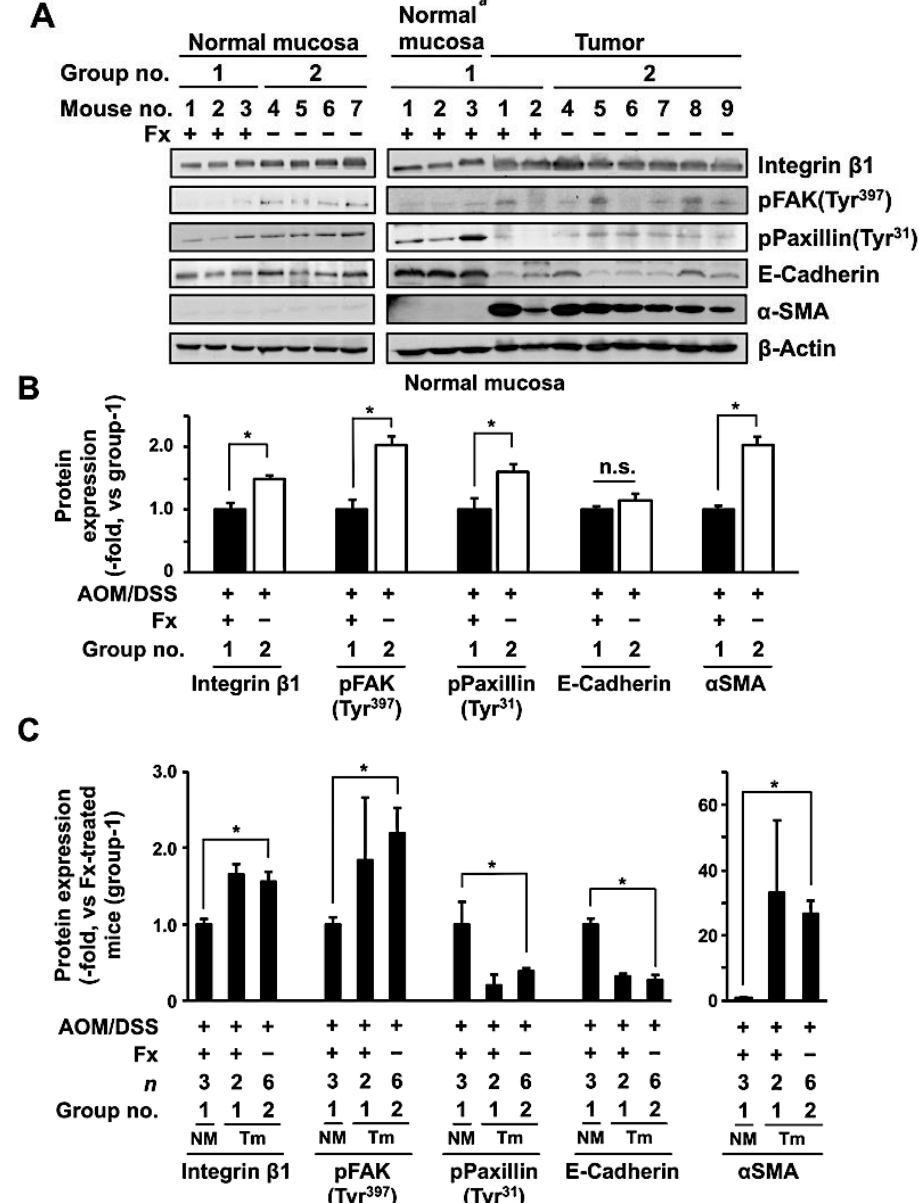
Figure 5. Protein expression in normal colorectal mucosa and tumor tissue from AOM/DSS mice with or without fucoxanthin (Fx) administration. ( A ) Normal colonic mucosa and tumors were collected, and indicated protein levels were evaluated by western blotting. The value of each band of ( B ) normal mucosa and ( C ) tumor was normalized to that of the β-actin band density from the image. ( B ) Each protein level in group 1 was set as 1.0. ( C ) Relative protein expression from tumor mucosa was quantified in comparison with normal mucosa of group 1. Mean ± SE ( n = 3–6). Significant difference was performed by Wilcoxon rank sum test. * p < 0.05. a Sample no. 1–3 in normal mucosa in group 1 are the same samples as those in group 1 in the left panel. NM, normal mucosa. Tm, tumor mucosa. Moreover, Integrin β1 (1.6-fold), E-cadherin (0.3-fold) and αSMA (26.6-fold) expression, and pFAK (Tyr 397 ) (2.2-fold) and pPaxillin (Tyr 31 ) (0.4-fold) altered in the tumors in group 2 compared with normal mucosa in group 1. Meanwhile, the expression and activation for these five proteins in tumors of group 1 were very similar to those of group 2 (Figure